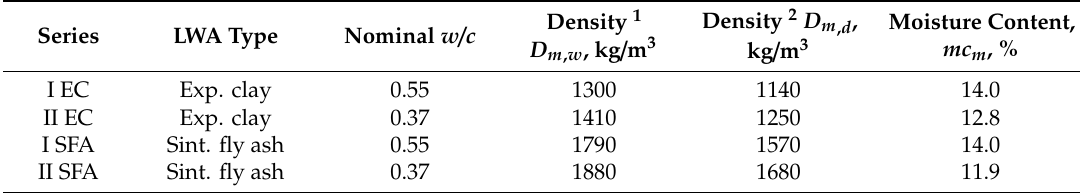
Table 5. Mean values of concrete density and moisture content determined on cored